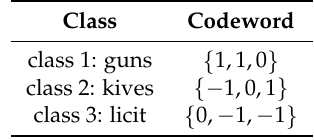
Table 1. Codeword generated by the ECOC classifier for each